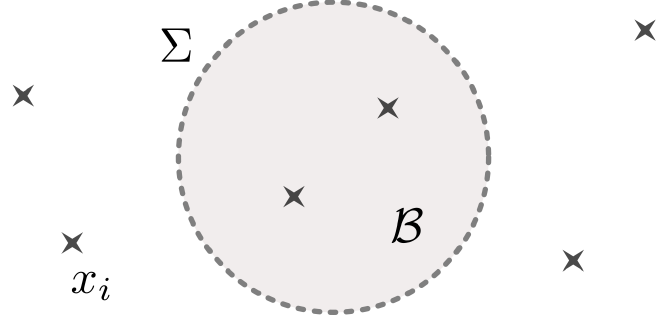
Figure 1 . Typical situation we consider. There are numerous field insertions, with a shaded domain in which fields are transformed, bounded by the dashed region of insertion of I